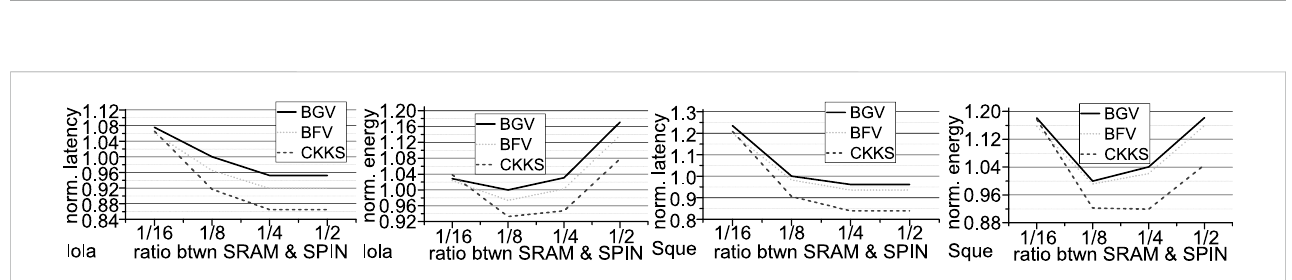
FIGURE 12 The design space exploration of the SRAM capacity in our NAND-SPIN and SRAM hybrid scratchpad memory (All are normalized to the BGV-based Lola having a ratio of 1/8).